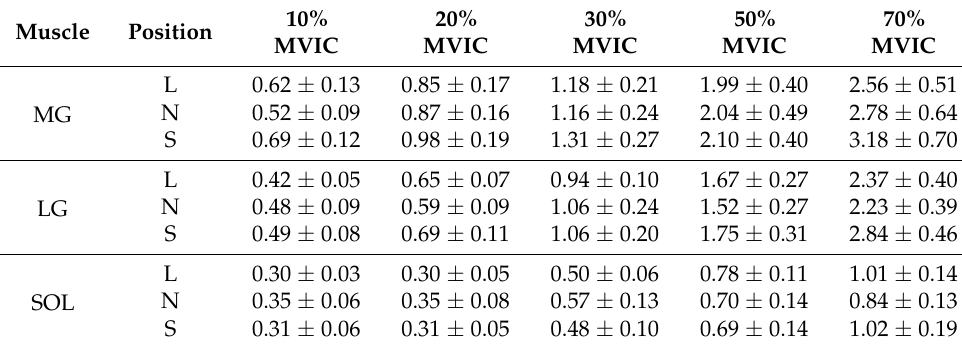
Table 1. Absolute variability of MG, LG, and SOL (MG SD , LG SD , and SOL SD ) at different contraction intensities and ankle joint angles. L: Longer muscle length (87°); N: Neutral muscle length (100°); S: Shorter muscle length (116°). Data shows as Mean ± SEM. Unit: µ